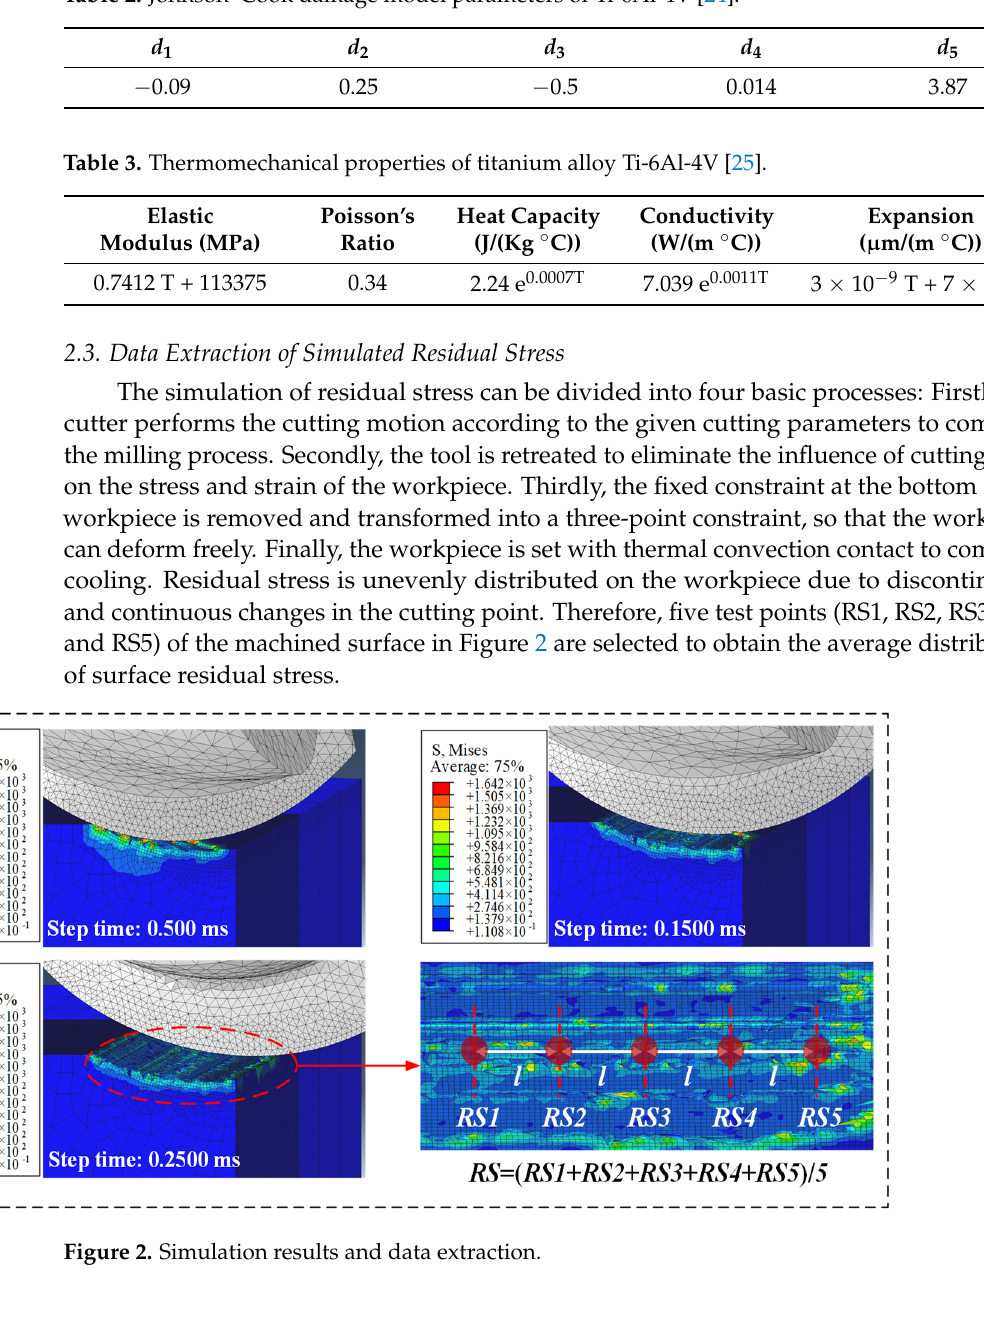
Table 2. Johnson–Cook damage model parameters of Ti-6Al-4V [24].